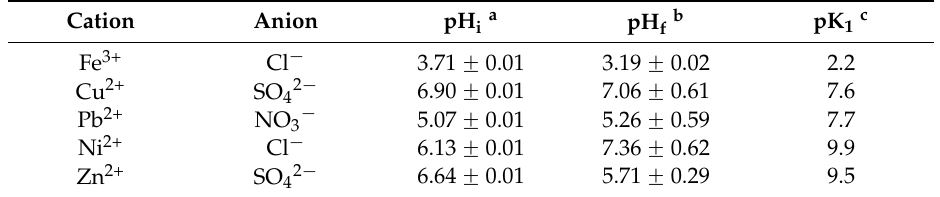
Table 2. Average pH before and after incubation with polymers 3a – g , and pK 1 for each metal ion solution. Cation Anion pH i